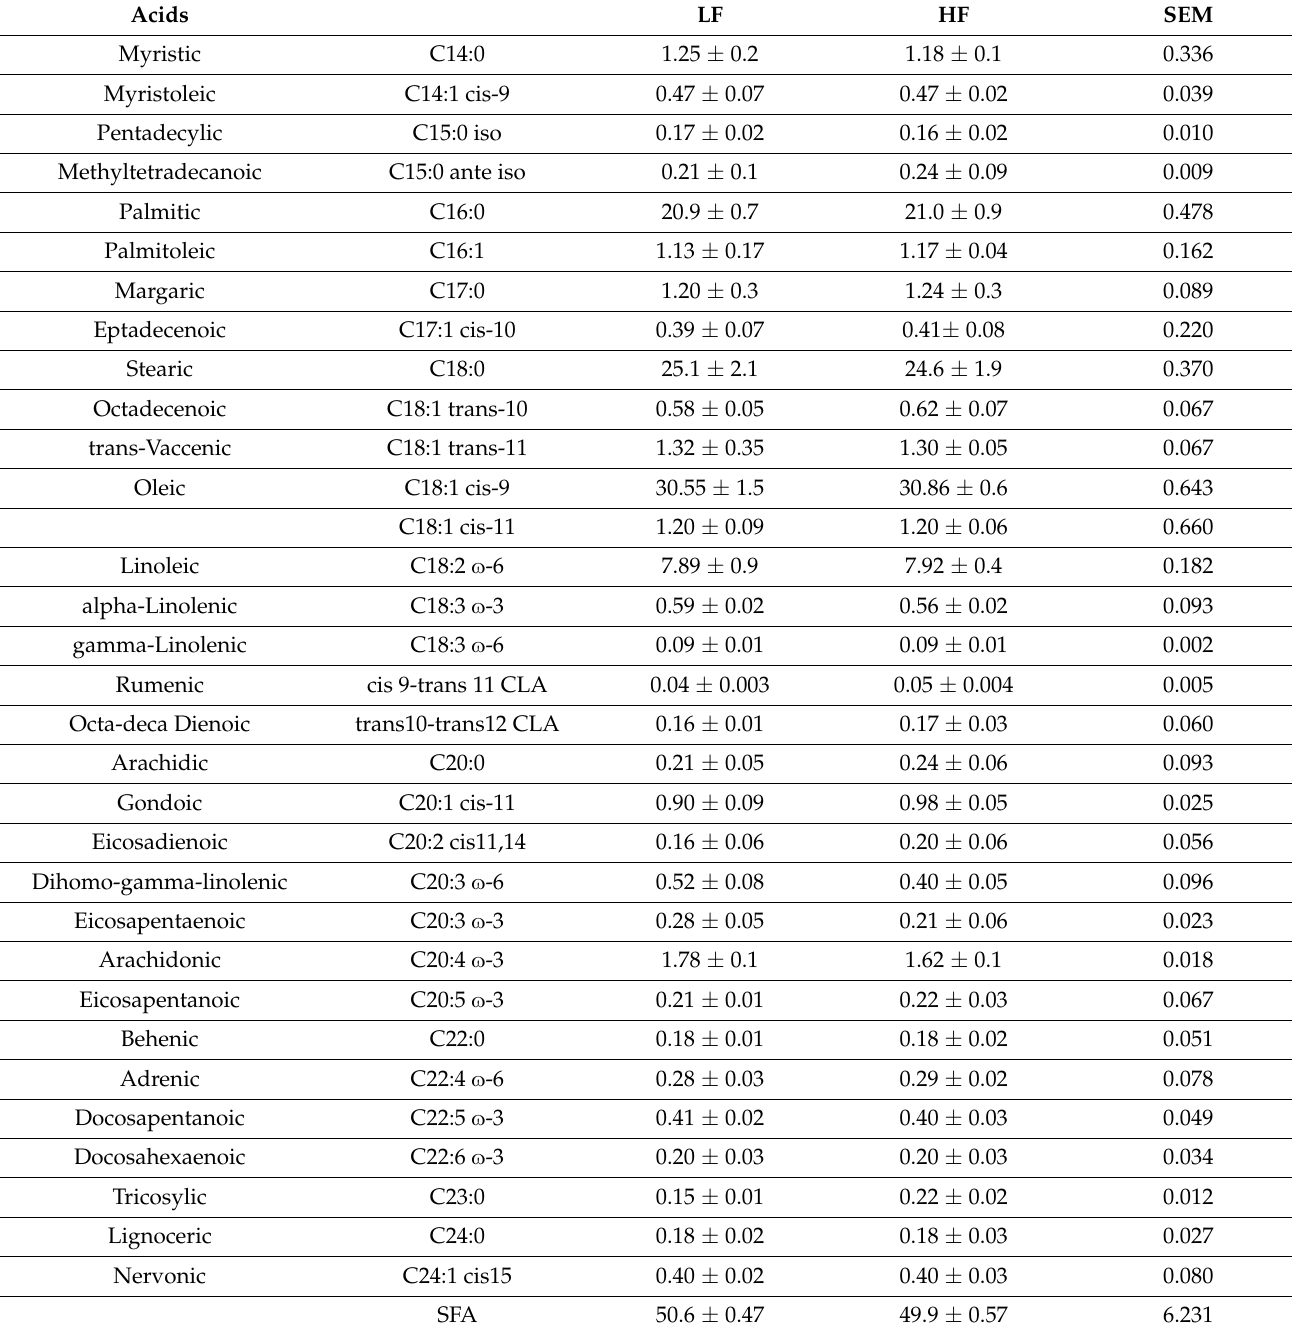
Table 5. Fatty acids composition of Longissimus thoracis muscle (g/100 g